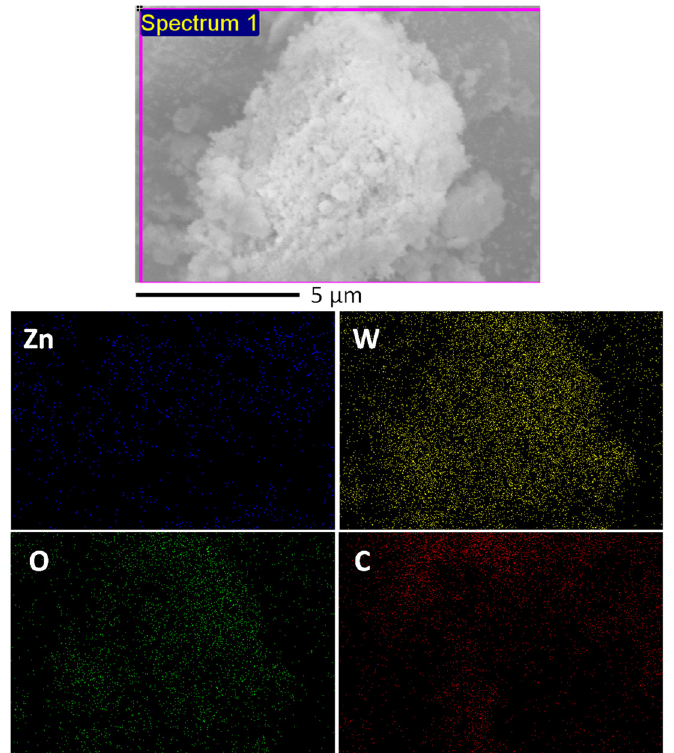
Figure 2. Elemental mapping analysis of the ZnWO 4 -NPs@rGO nanocomposites.